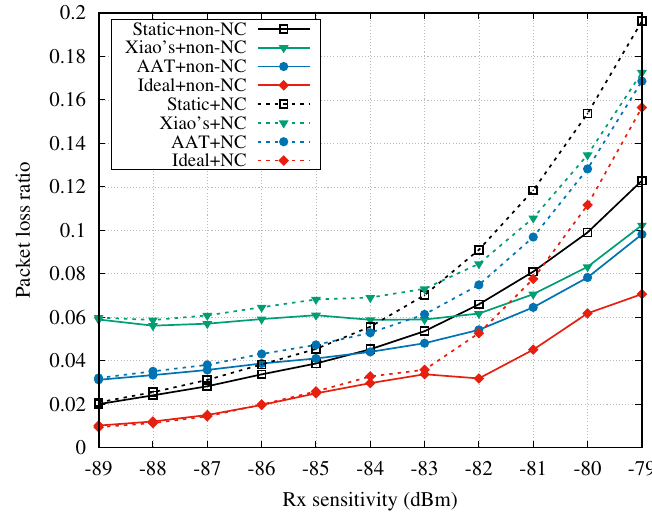
Figure 10. Packet loss ratio vs. Rx sensitivity.